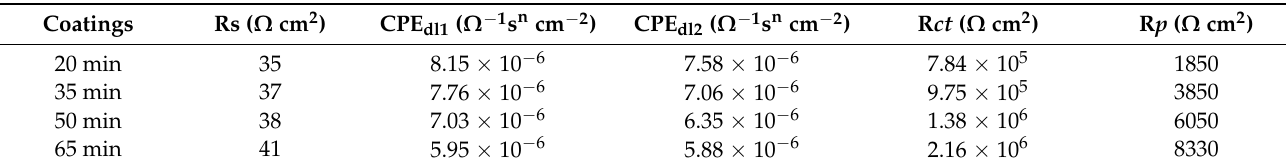
Table 4. Characteristic of the equivalent circuit derived from the EIS spectra.